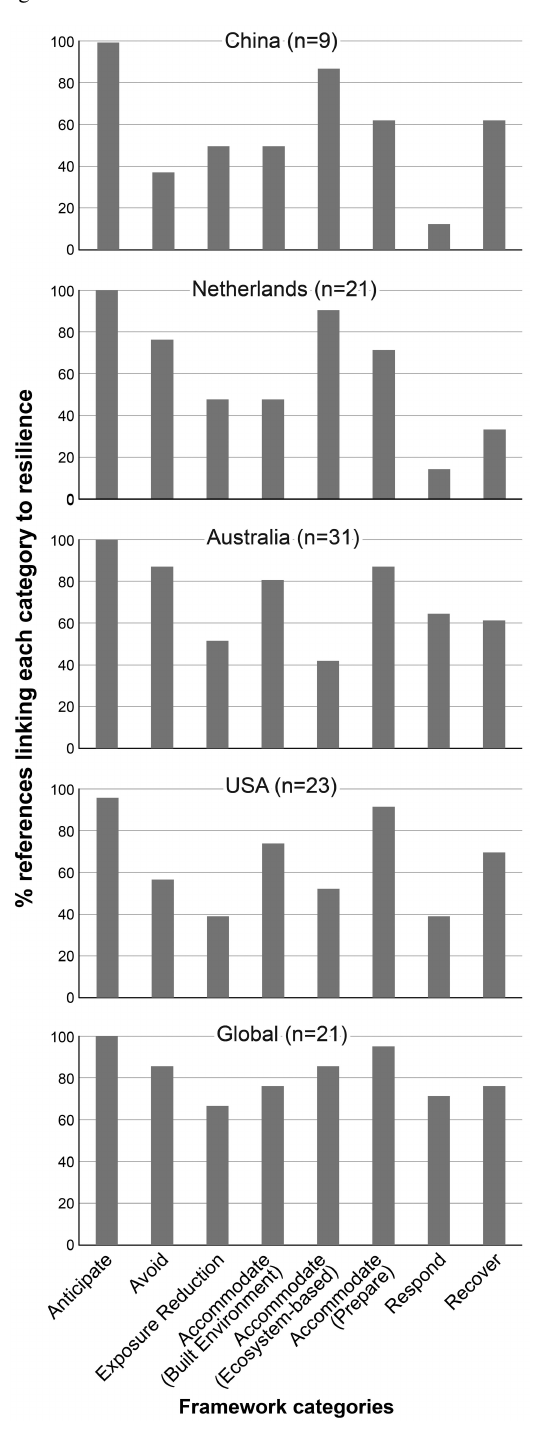
Fig. 1 . The relative significance of framework categories for each case study. Graphs indicate the percentage of references (total = n) that link at least one activity in a category to resilience. Activities associated with each category are listed in Appendix 1. Note the category “accommodate” has been divided into three subcategories to make it easier to distinguish strategies covered in the discussion.